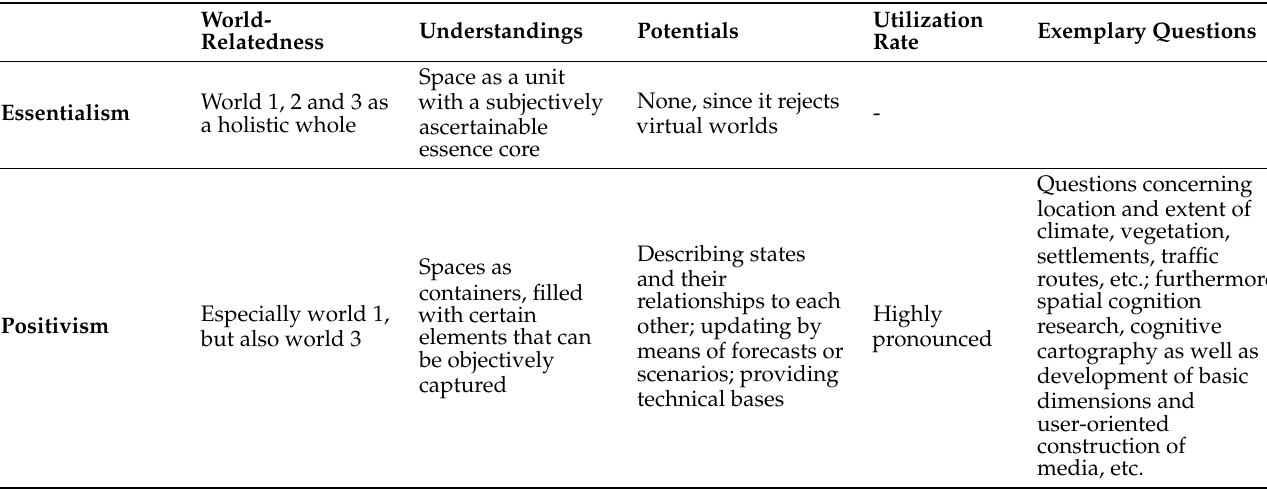
Table 1. Overview of the different approaches discussed. The world reference used here in the second column goes back to Karl Popper. He understands world 1 as the material world [171,172], world 2 as the world of individual consciousness, and world 3 as the world of socially shared knowledge. The worlds are not structurally separated from each other, but connect, for example in books, which are part of world 1 and world 3 (own